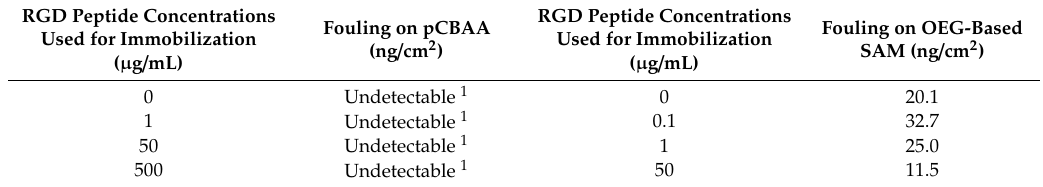
Table 1. Fouling from the cell growth medium containing 10% fetal bovine serum on arginine, glycine, and aspartic acid (RGD)-functionalized coatings. The incubation time was 60 min; more experimental details are provided in the Supplementary